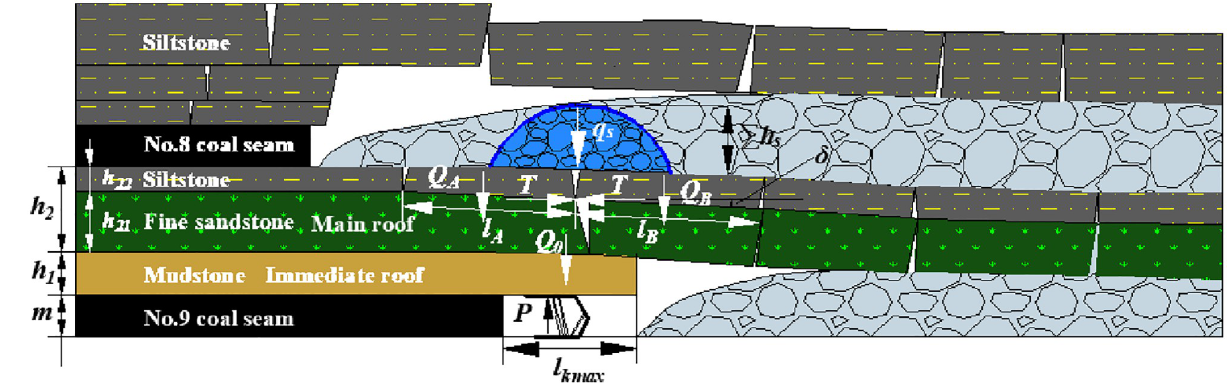
Fig 12. Roof structure characteristic after No.9 coal seam mining.